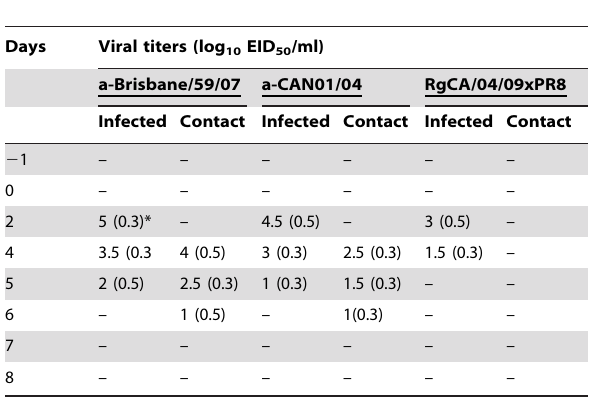
Table 3. Nasal excretion of CA/04/09 in vaccinated ferrets.